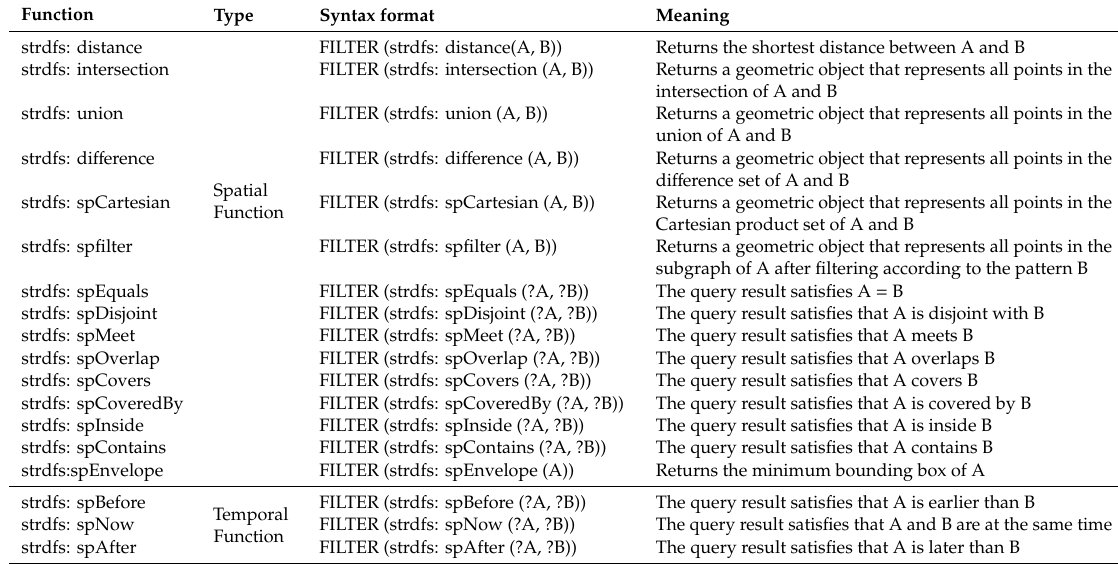
Table 2. Spatiotemporal